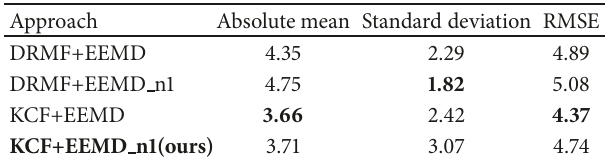
Table 4: Comparison of heart rate estimations using different features (best performance in